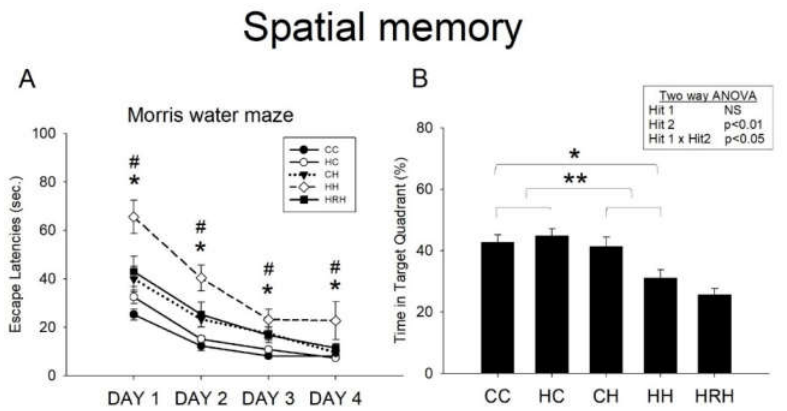
Figure 6. Spatial learning and memory test assessed by the Morris water maze. ( A ) Escape latency to the platform in the Morris water maze (mean ± SEM). Rats in the HH group swam for a longer time to find the submerged platform on all four acquisition days compared to rats in the CC, HC, and CH groups. HRH group rats took less time to reach the platform compared to rats in the HH group. Maternal HFD / obesity on escape latencies: (F (1,36) = 13.949, p = 0.001). Postnatal HFD